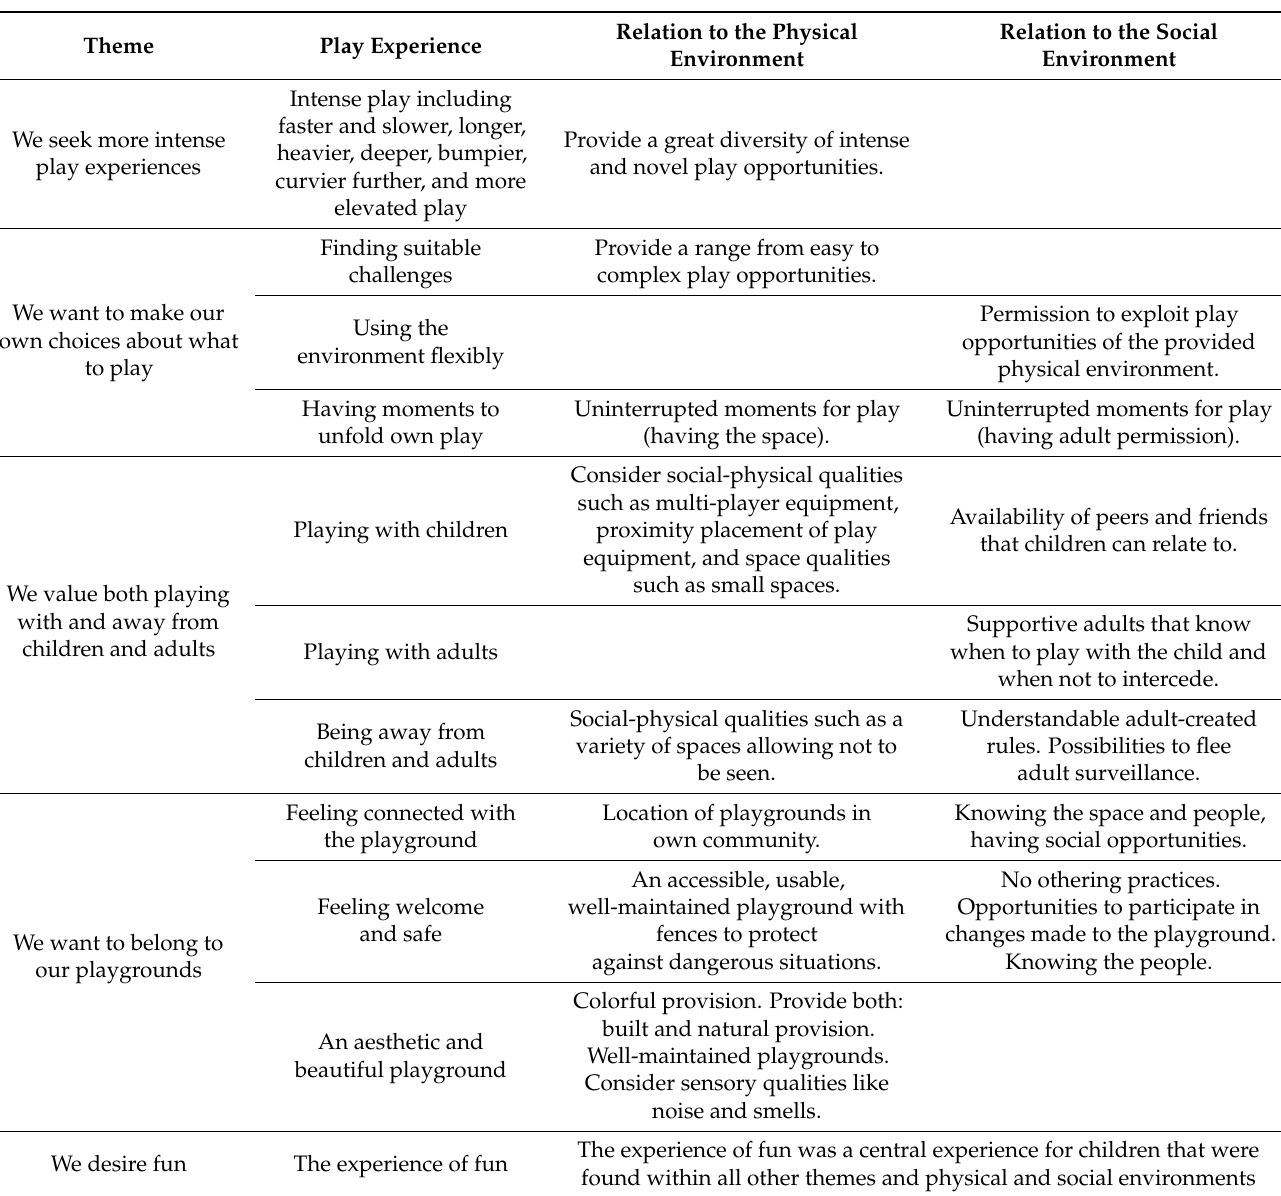
Table 4. Enhancing outdoor play: The relation between children’s play experiences and the physical and social